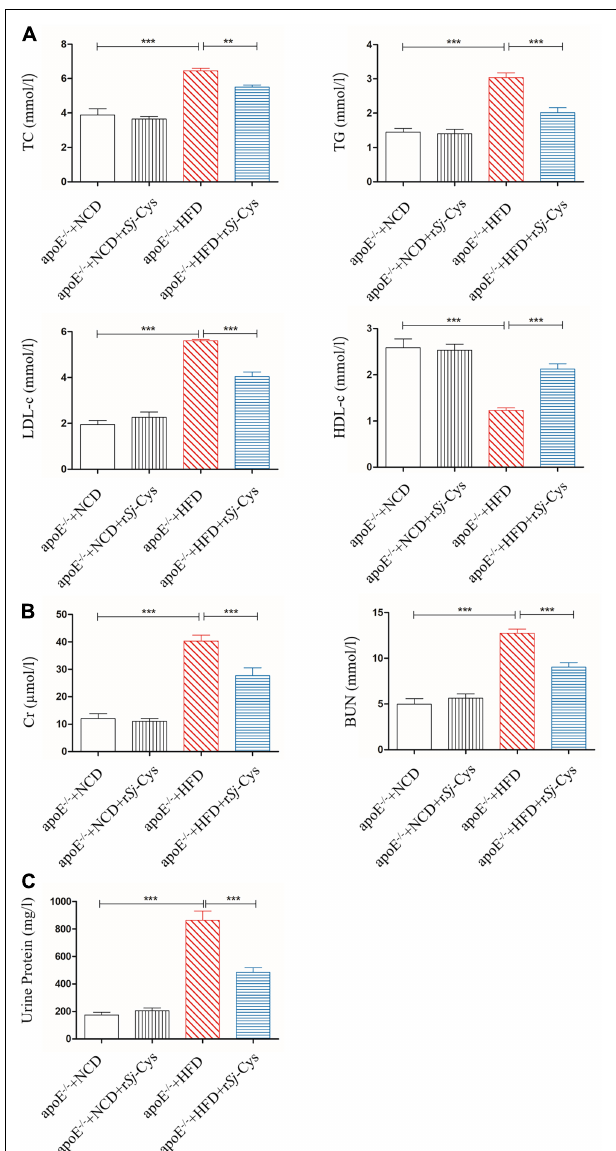
FIGURE 5 | r Sj -Cys reduced the serum lipid levels and improved renal function. (A) The changes of TC, TG, LDL-c, and HDL-c in sera. (B) r Sj -Cys reduced the levels of Cr and BUN in sera. (C) r Sj -Cys reduced the levels of urine protein. The data are shown as the mean ± SEM for each group ( n = 6 per group). ** P < 0.01, *** P <